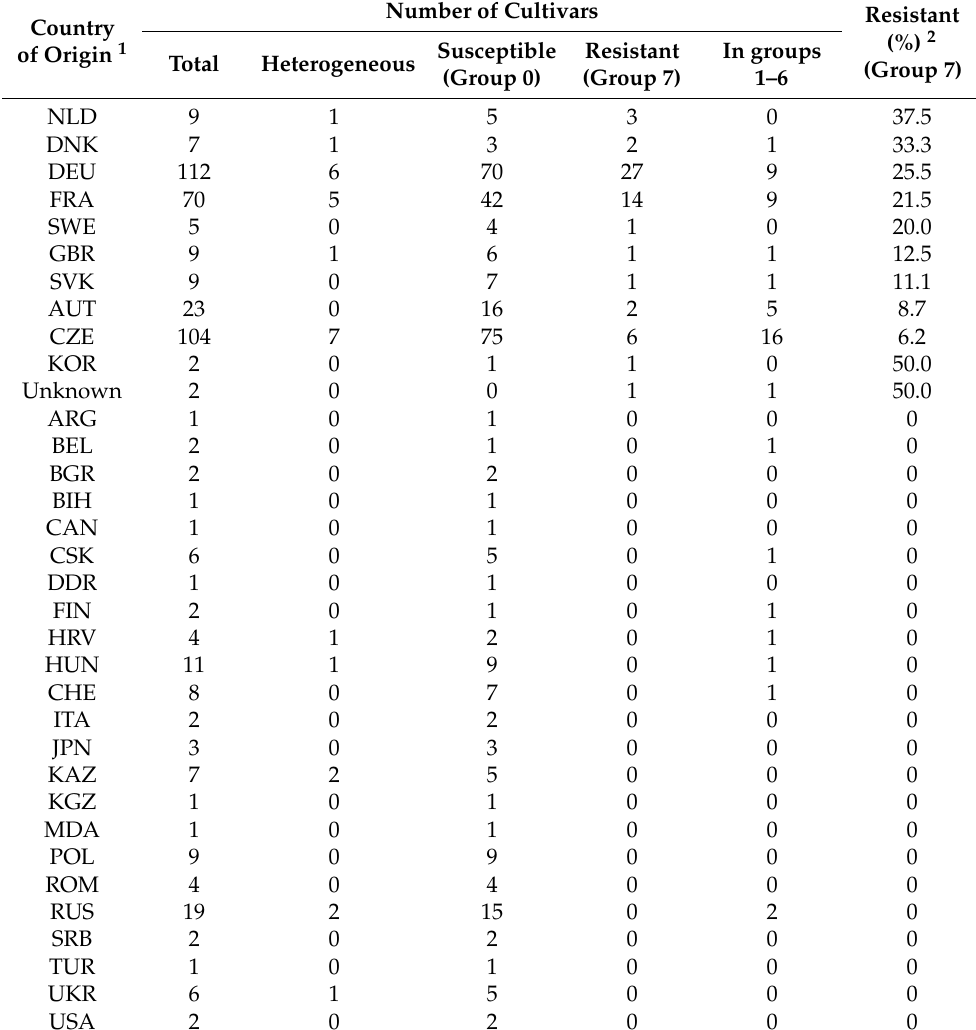
Table 3. The number of wheat cultivars according to their country of origin and designation as heterogeneous, susceptible or resistant to three powdery mildew